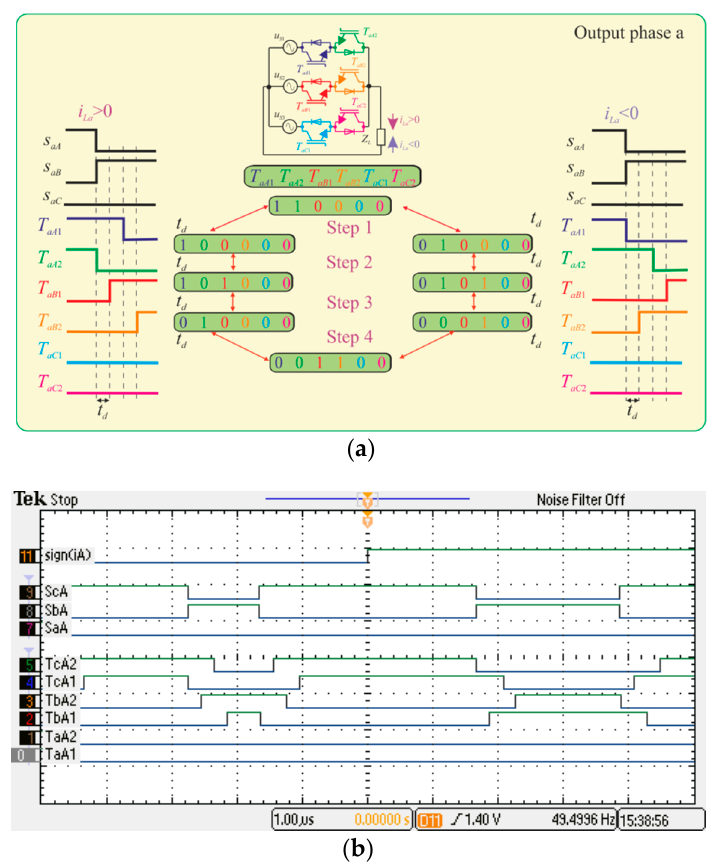
Figure 12. Four-step commutation process in one output phase of the MC: ( a ) switching diagram; ( b )